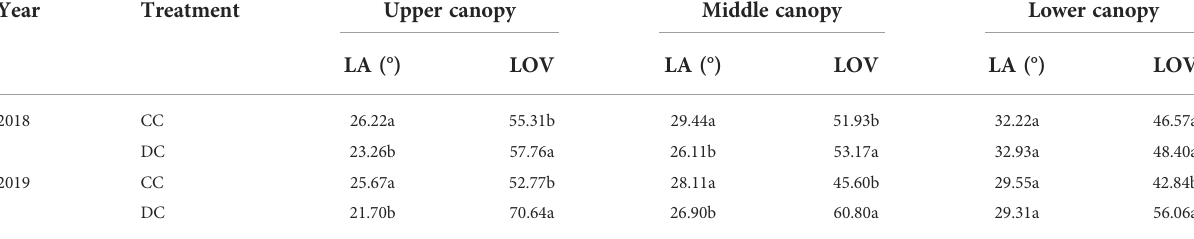
TABLE 2 Leaf angle and leaf orientation value of different canopies at the R1 stage.